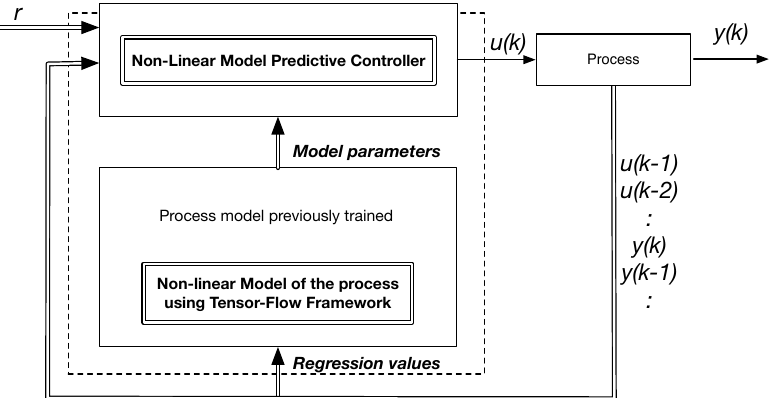
Figure 1. System Architecture for the implementation of a Tensor Flow model-based control system.